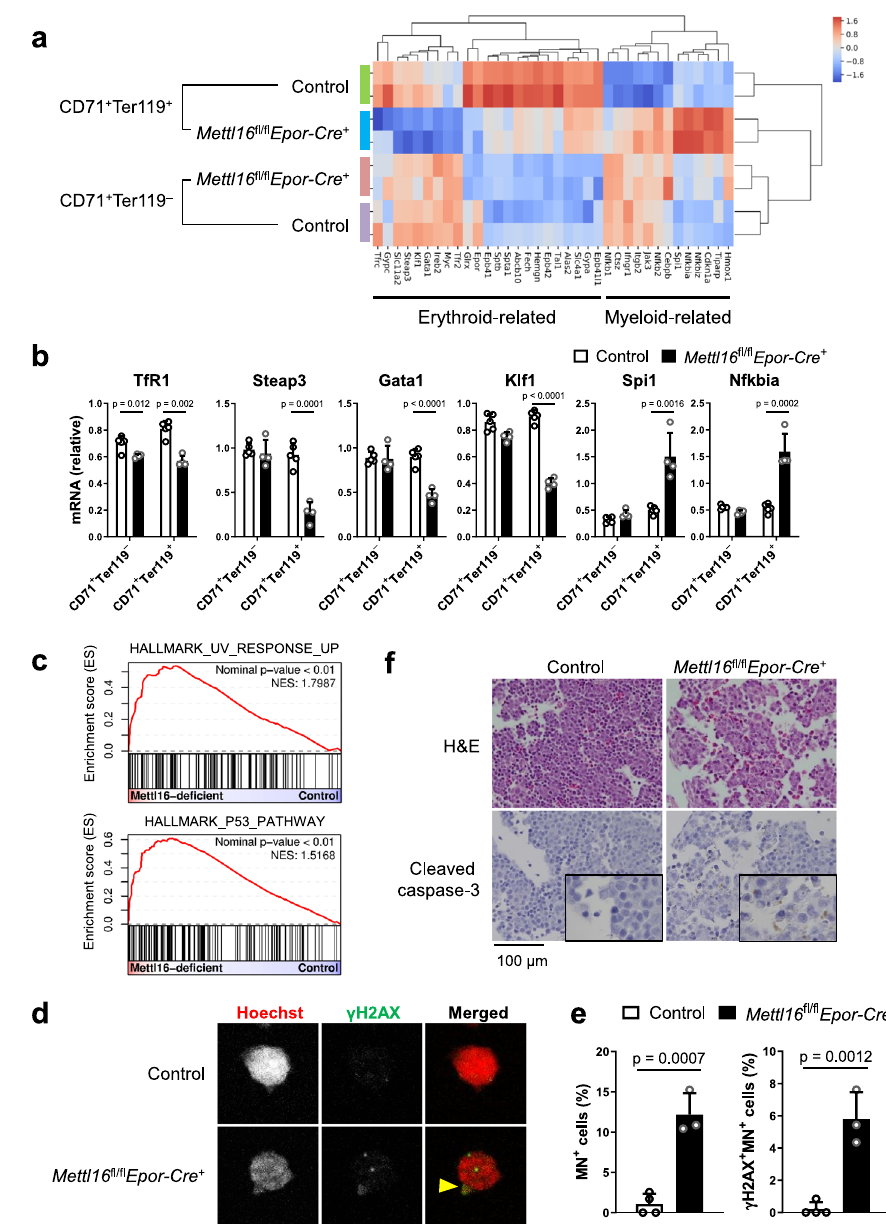
Fig.3|METTL16isrequiredformaintenanceoferythroididentityandgenome integrity. a Heatmap showing the relative mRNA expression levels of erythroid- related and myeloid-related genes in the erythroblasts from E11.5 control and Mettl16 fl / fl Epor-Cre + mice. b mRNA expression levels of erythroid-related and myeloid-related genes in the erythroblasts from control ( n =5 mice) and E11.5 Mettl16 fl / fl Epor-Cre + mice ( n =4 mice). mRNA expression levels of genes were nor- malized to the expression level of β -actin ( Actb ). c GSEA plot showing the enrich- mentof thehallmarksofUVresponse and p53pathwayinerythroblastsfrom E11.5 Mettl16 fl / fl Epor-Cre + mice. Statistical analysis was performed using GSEA software. d , e CD71 + Ter119 + erythroblastsoftheFLfromE11.5controland Mettl16 fl / fl Epor-Cre + mice stained by Hoechst 33342 (red) and anti- γ H2AX antibody (green) and